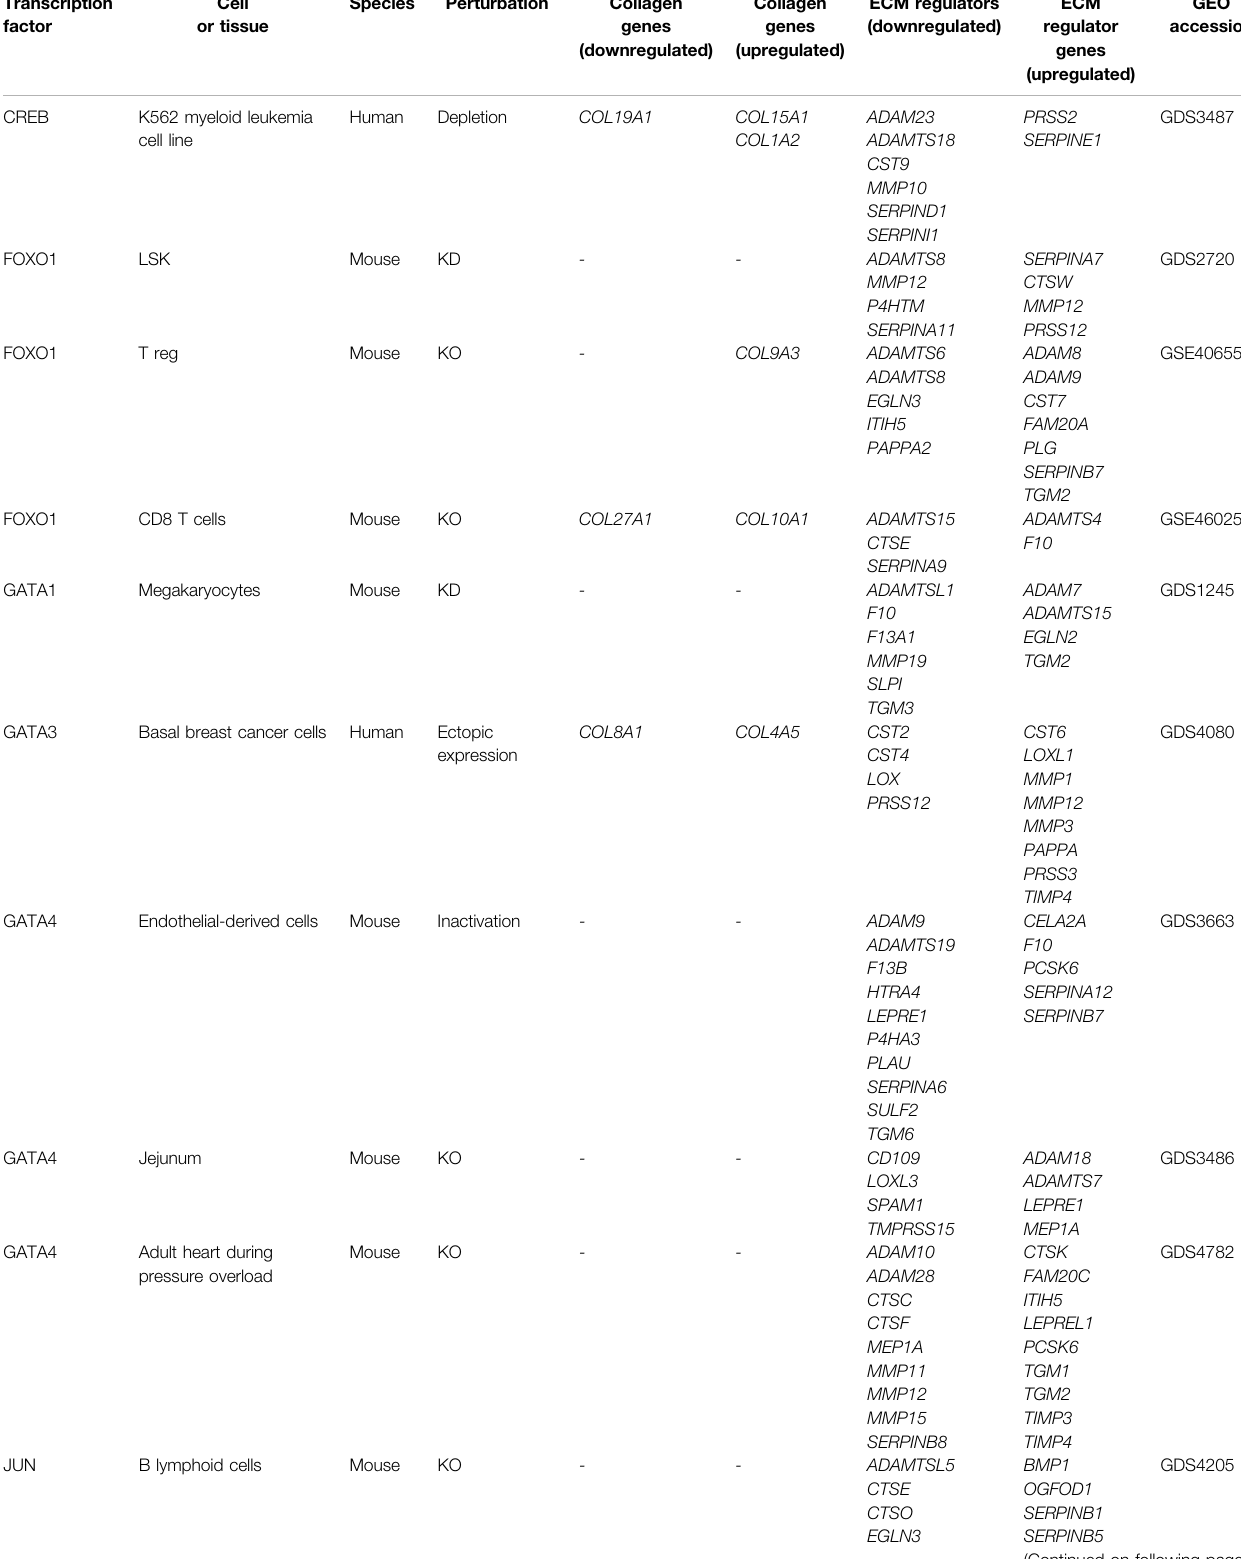
TABLE 2 | List of collagen and ECM regulator genes differentially regulated after transcription factor perturbation. KD = knockdown; KO = knockout; OE =